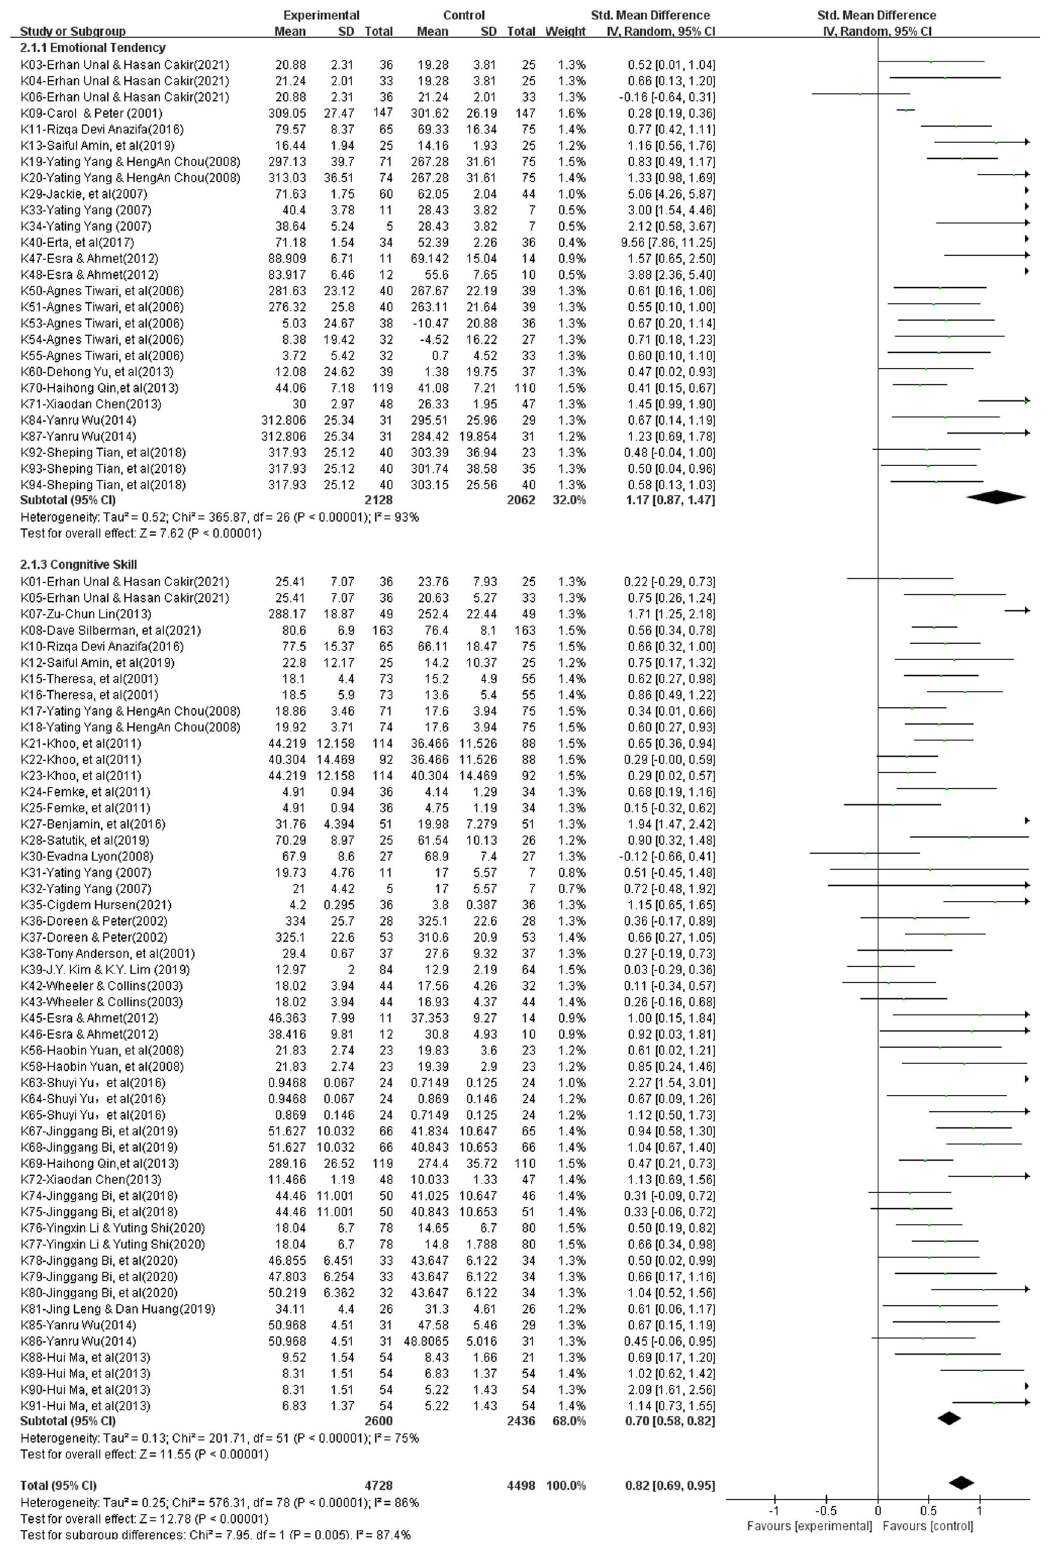
Fig. 3 Forest plot representing the overall effect of 36 studies. This forest plot shows the analysis result of the overall effect size across 36